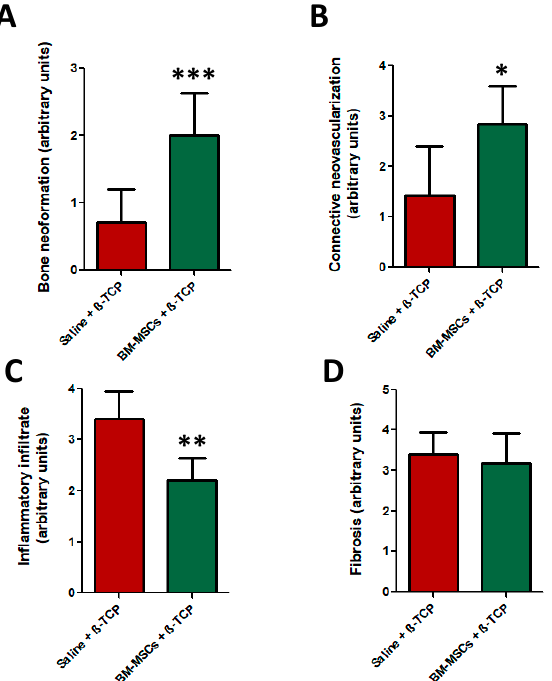
Figure 5. Evaluation of the effect of BM-MSC mediated bone neoformation, connective tissue neovascularization, inflammatory infiltrate and degree of fibrosis. ( A ) Maxillary bone of BM-MSC + β -TCP-treated animals showed a significant degree of bone neoformation; ( B ) connective tissue neovascularization and ( C ) significant lower inflammatory infiltrate, * p < 0.05, ** p < 0.01 and *** p < 0.001, respectively; ( D ) however, the degree of fibrosis was not significantly different between both experimental groups.